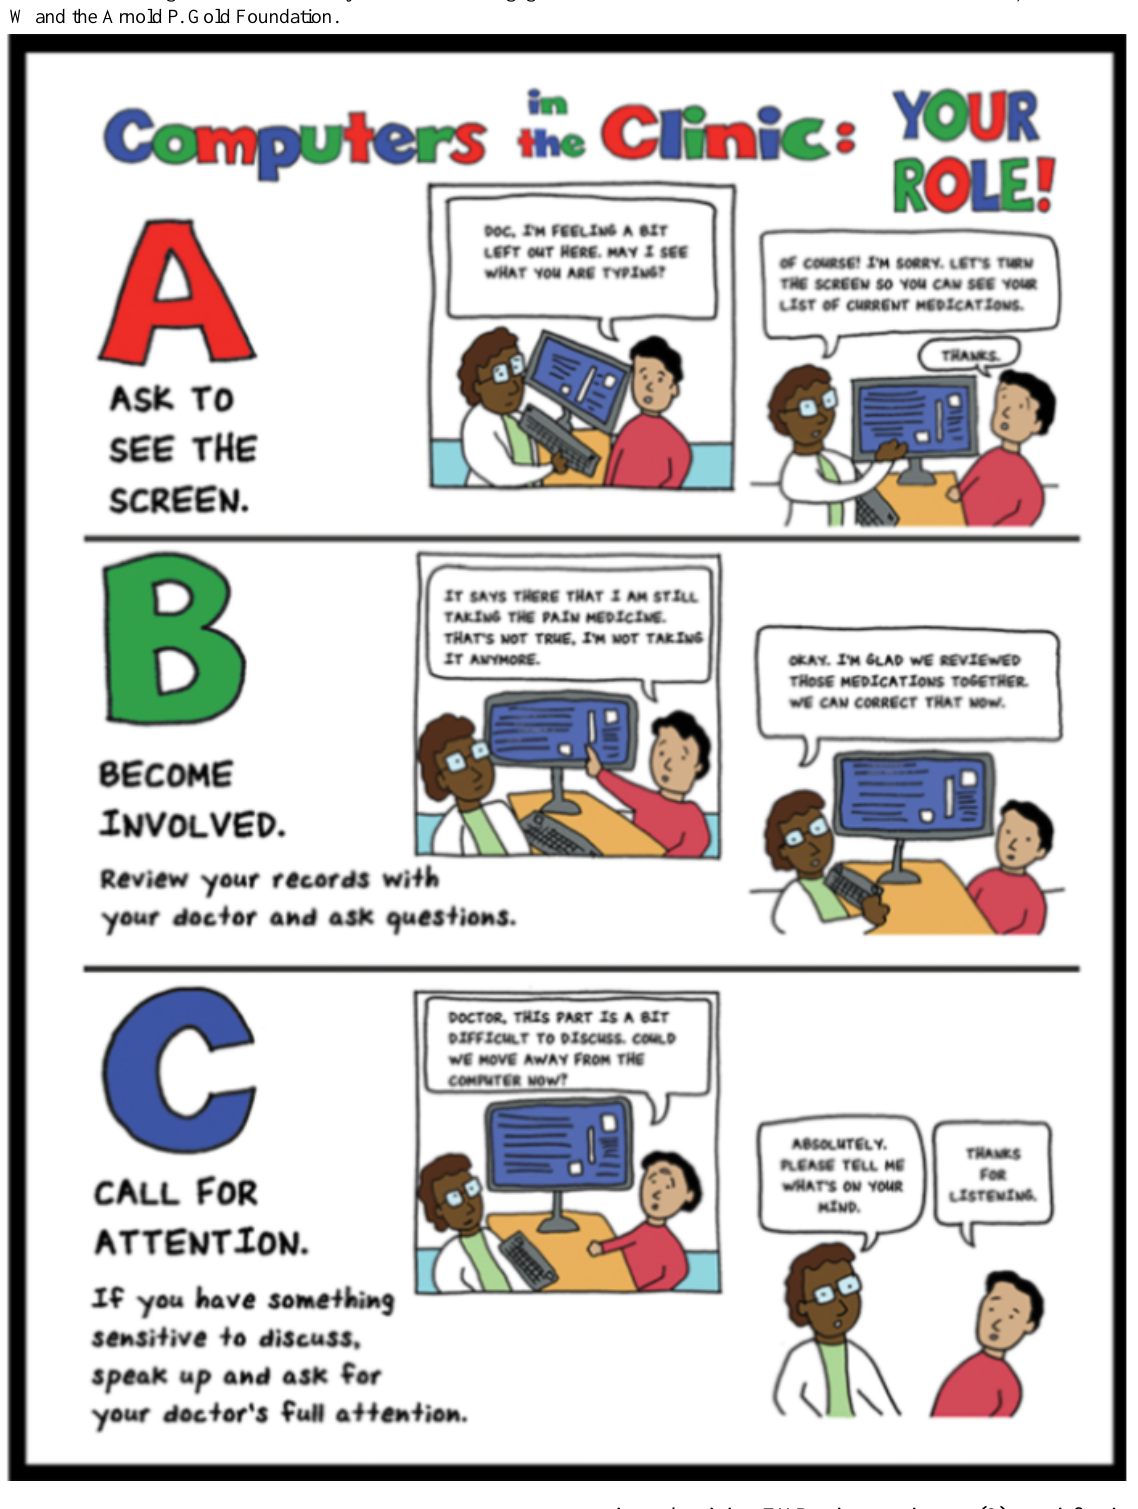
Figure 1. Patient EHR self-advocacy comic. The educational comic was given to adult patients and parents of pediatric patients when registering for their clinic visits to encourage EHR self-advocacy behaviors and engagement. EHR: electronic health record. © Alkureishi ML, Czerwiec MK, Arora V, Lee WW and the Arnold P. Gold